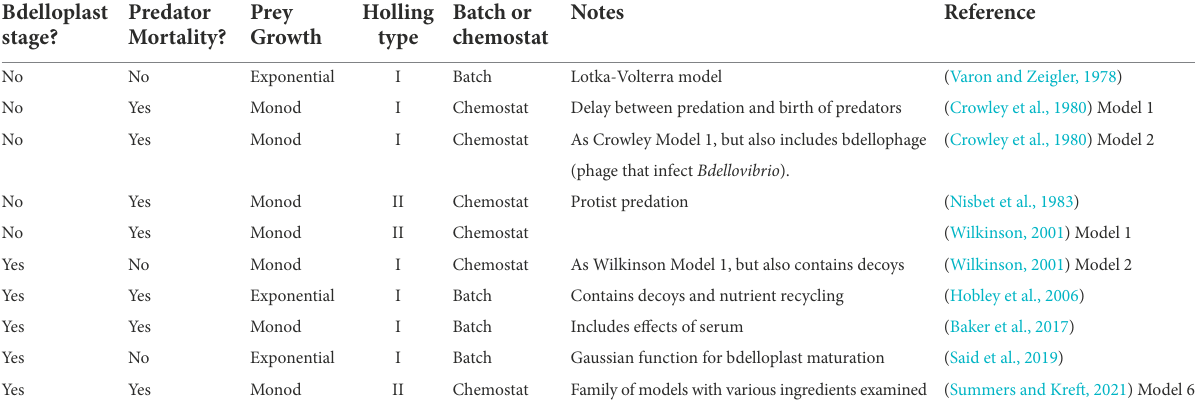
TABLE 2 Previous models of Bdellovibrio and other relevant microbial predators, taken from Table S1 in Summers and Kreft (2021) and compared to their principal model 6. Bdelloplast